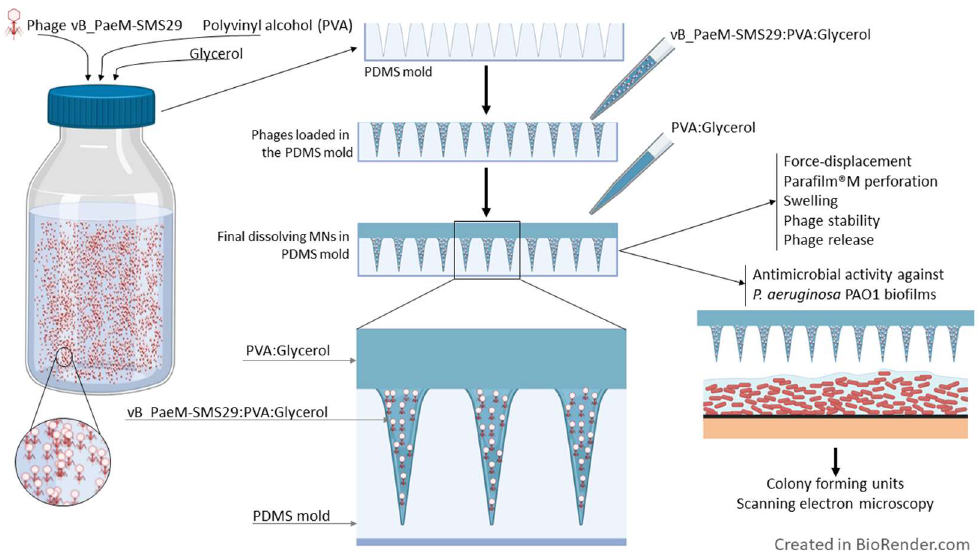
Scheme 1. Overview of the experiments performed to characterize microneedles loaded with phages and evaluate their efficacy against